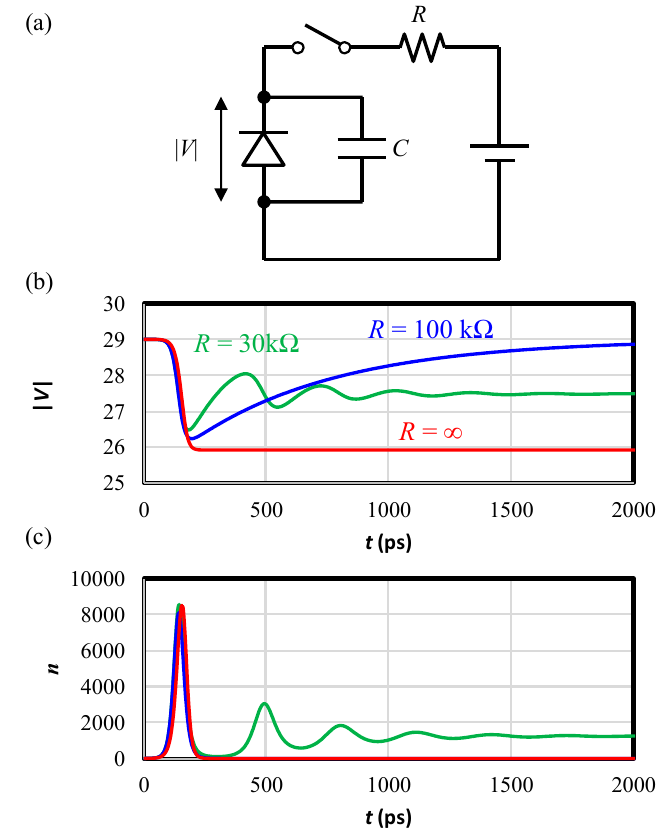
Figure 9. ( a ) A model circuit for a resistive quenching. ( b ) Calculated reverse biases for R = 100 k Ω (blue) R = 30 k Ω (green) R = ∞ (red). ( c ) Carrier numbers for R = 100 k Ω (blue) R = 30 k Ω (green) R = ∞ (red). Capacitance is 6fF for all conditions.